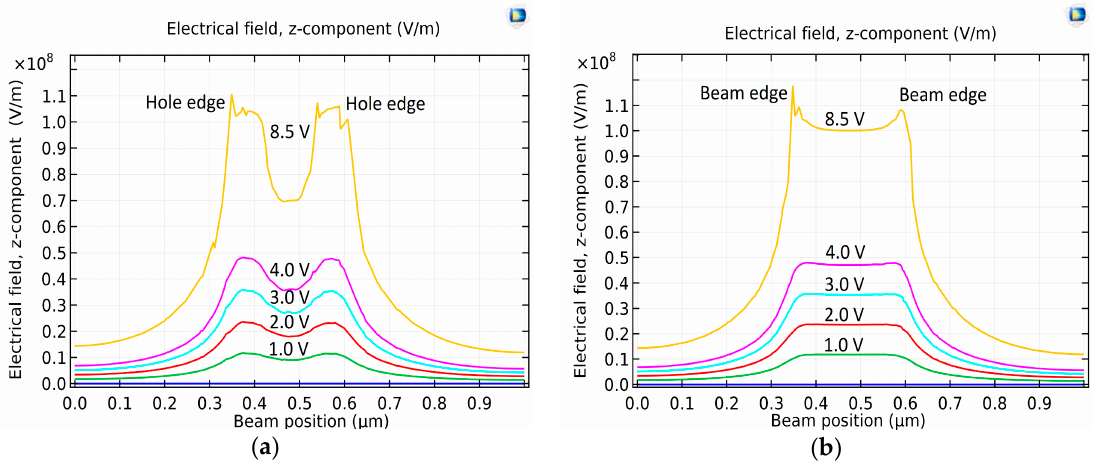
Figure 15. z -displacement of the electrical field at dissimilar applied voltages between: ( a ) gold bottom electrode and perforated graphene beam; ( b ) gold bottom electrode and intact graphene beam.